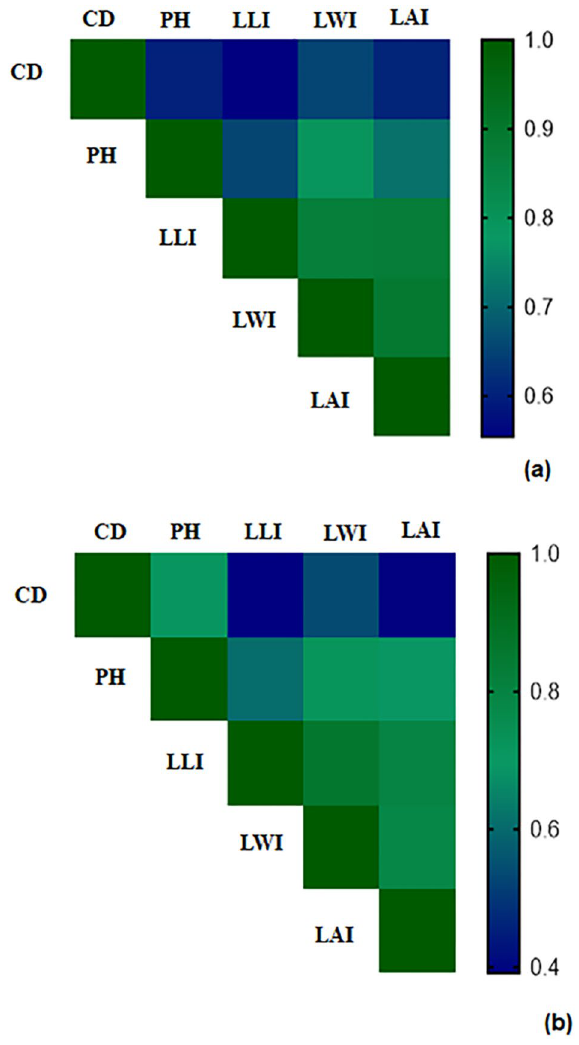
Figure 2. Pearson correlation analysis of morphological traits of ( a ) ‘Atabaki’ and ( b ) ‘Rabab’ in response to exogenous GABA application and drought and salinity stress. PH plant height, CD crown diameter, LLI leaf length index, LWI leaf width index, LAI leaf area